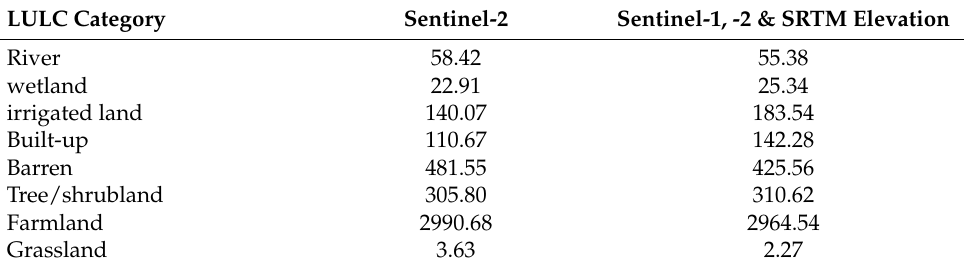
Table 8. Area proportion (km 2 ) for each LULC